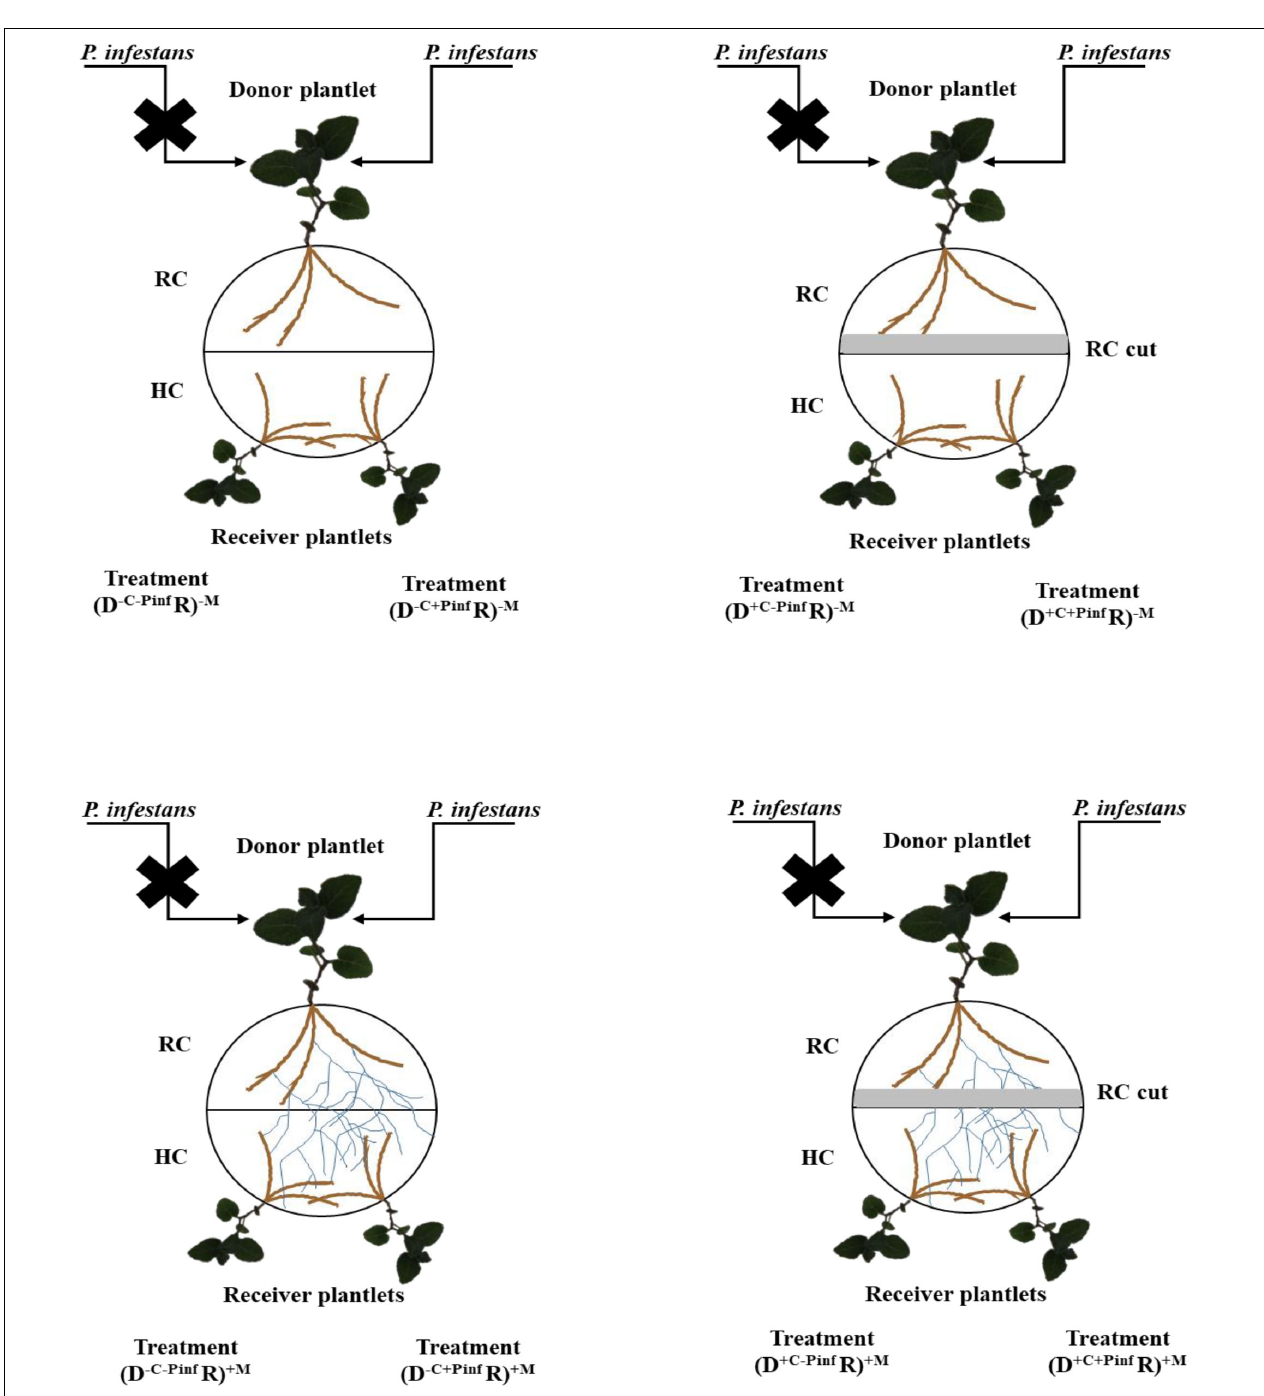
FIGURE 1 | Schematic representation of the in vitro experimental system. Warning signal transmission was investigated from a donor (D) potato plantlet infected by Phytophthora infestans MUCL 54981 to two uninfected receiver (R) potato plantlets linked by a common mycorrhizal network of the arbuscular mycorrhizal fungus, Rhizophagus irregularis MUCL 41833. The plantlets developed in separate compartments (a root compartment, RC and a hyphal compartment, HC) physically separated by a plastic wall, while the AMF crossed the wall and interconnected the plants. Several treatments were considered, depending on whether the roots of the donor (D) plantlet were colonized or not by the AMF (+M, − M), the shoot infected of not by P. infestans (+Pinf, − Pinf), and the medium in the RC cut or not (+C, − C): (D − C − Pinf R) + M , (D + C − Pinf R) + M , (D + C + Pinf R) + M and (D − C + Pinf R) + M , (D + C − Pinf R) − M , (D + C + Pinf R) − M , (D − C + Pinf R) − M , (D − C − Pinf R) − M .